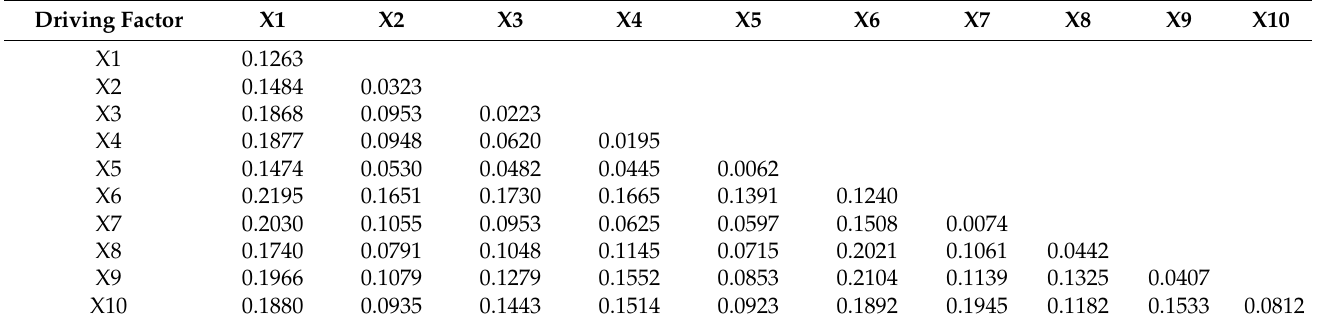
Table 7. Interactions between the driving factors of spatial differentiation of IESV.